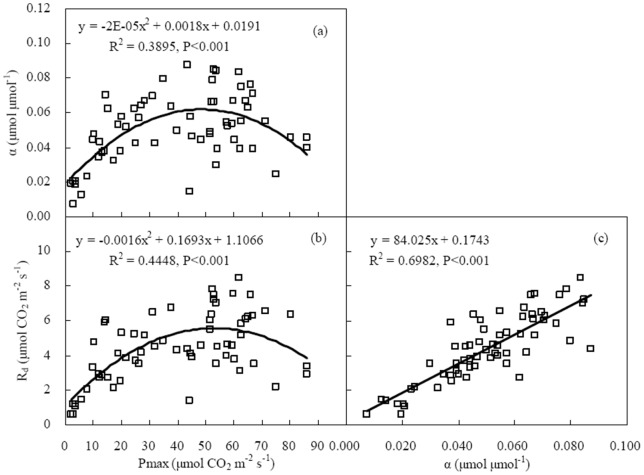
Relationships among initial light use efficiency (α), maximum photosynthetic capacity (P
max), and daytime ecosystem respiration under dark conditions (R
d) at 5-day intervals during the main growing season of winter wheat.